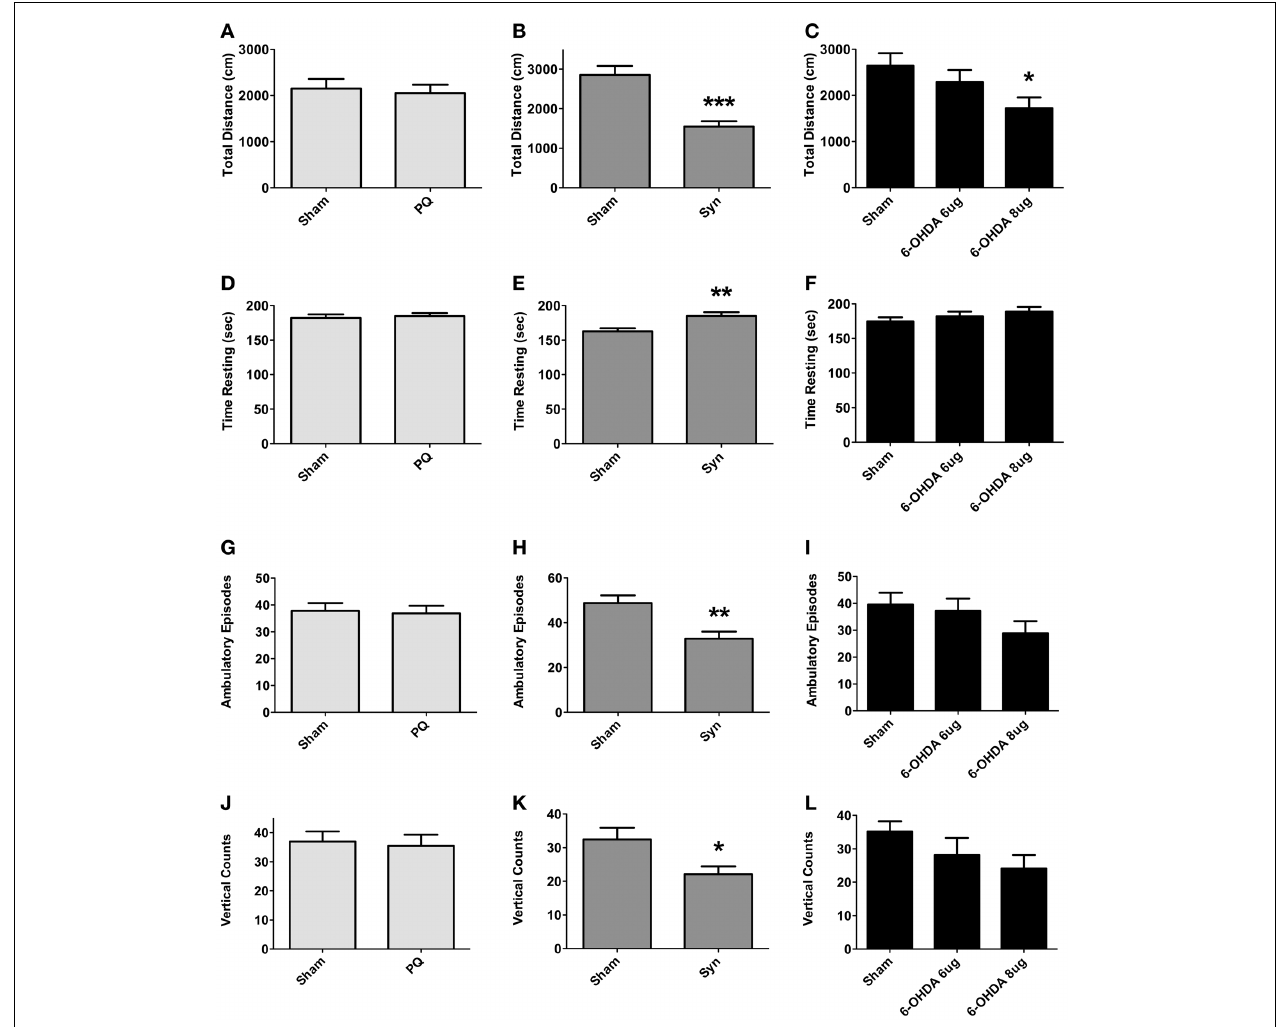
FIGURE 4 | Locomotory and exploratory activity. Differences in total distance traveled (A–C) , time in rest (D–F) , number of ambulatory episodes (G–I) and number of rearings (J–L) . Data expressed as mean ± s.e.m. ∗ p < 0 . 05, ∗∗ p < 0 . 01, and ∗∗∗ p < 0 .